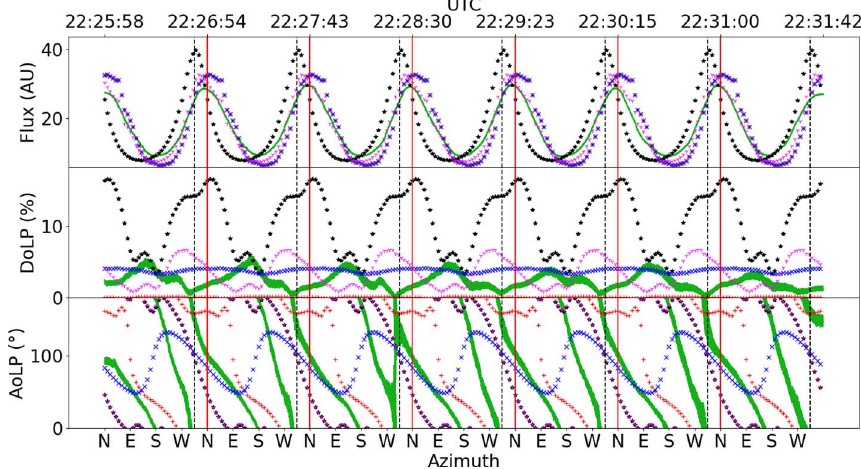
Fig. 7. In green, the observations of the polarisation fl ux (top), DoLP (middle), and AoLP (bottom) at 557.7 ± 5 nm over 7 almucantars on February 27, 2020. The thickness indicates the uncertainties). A sliding average of 10 s is applied. Black stars ( H ): Contribution of the ground emissions G . Red plus (+): Contribution of the sky emission and its re fl ection on the snow S . Pink (Y): Linear combination of the ground and sky contributions that best fi ts the fl ux variations. Blue crosses ( (cid:2) ): Direct light only (i.e., not scattered in the atmosphere, no other sources that could be scattered by the atmosphere are taken into account) with a polarisation at the emission (here d max = 5% and the electrons motion direction is 50 (cid:3) azimuth and (cid:3) 20 (cid:3) elevation). The dashed vertical black line indicates the direction of Skibotn. The picture of the sky at 557.7 nm at the time of the observation is shown in Appendix